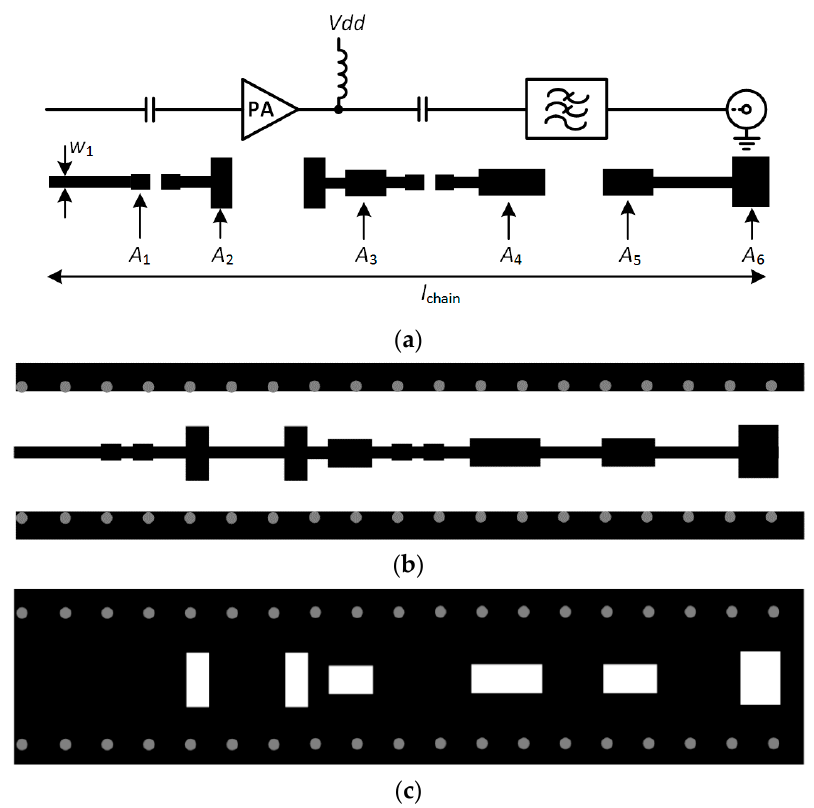
Figure 5. Amplifier chain: Simulated circuit schematic and footprint landpads on L1 layer ( a ); simulated amplifier chain with all components bypassed by connecting them with a transmission line on L1 layer ( b ) and reference plane with cutouts under pads as a compensation on layer L2 ( c ).